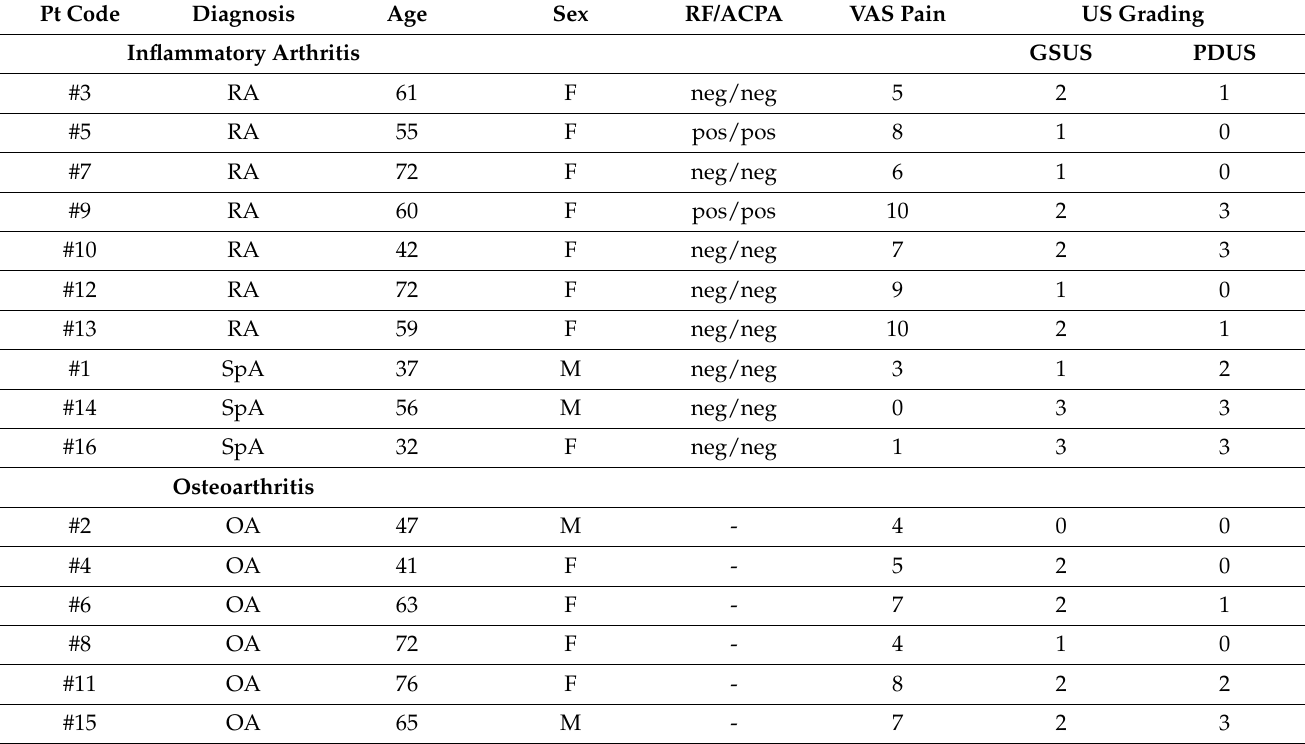
Table 1. Table summarizing demographic, clinical, and ultrasonographic characteristics of all the six- teen patients included in the study. Even though ten patients were affected by inflammatory arthritis (seven RA and three SpA) and six patients had primary OA, a comparable level of inflammation was detected among all of